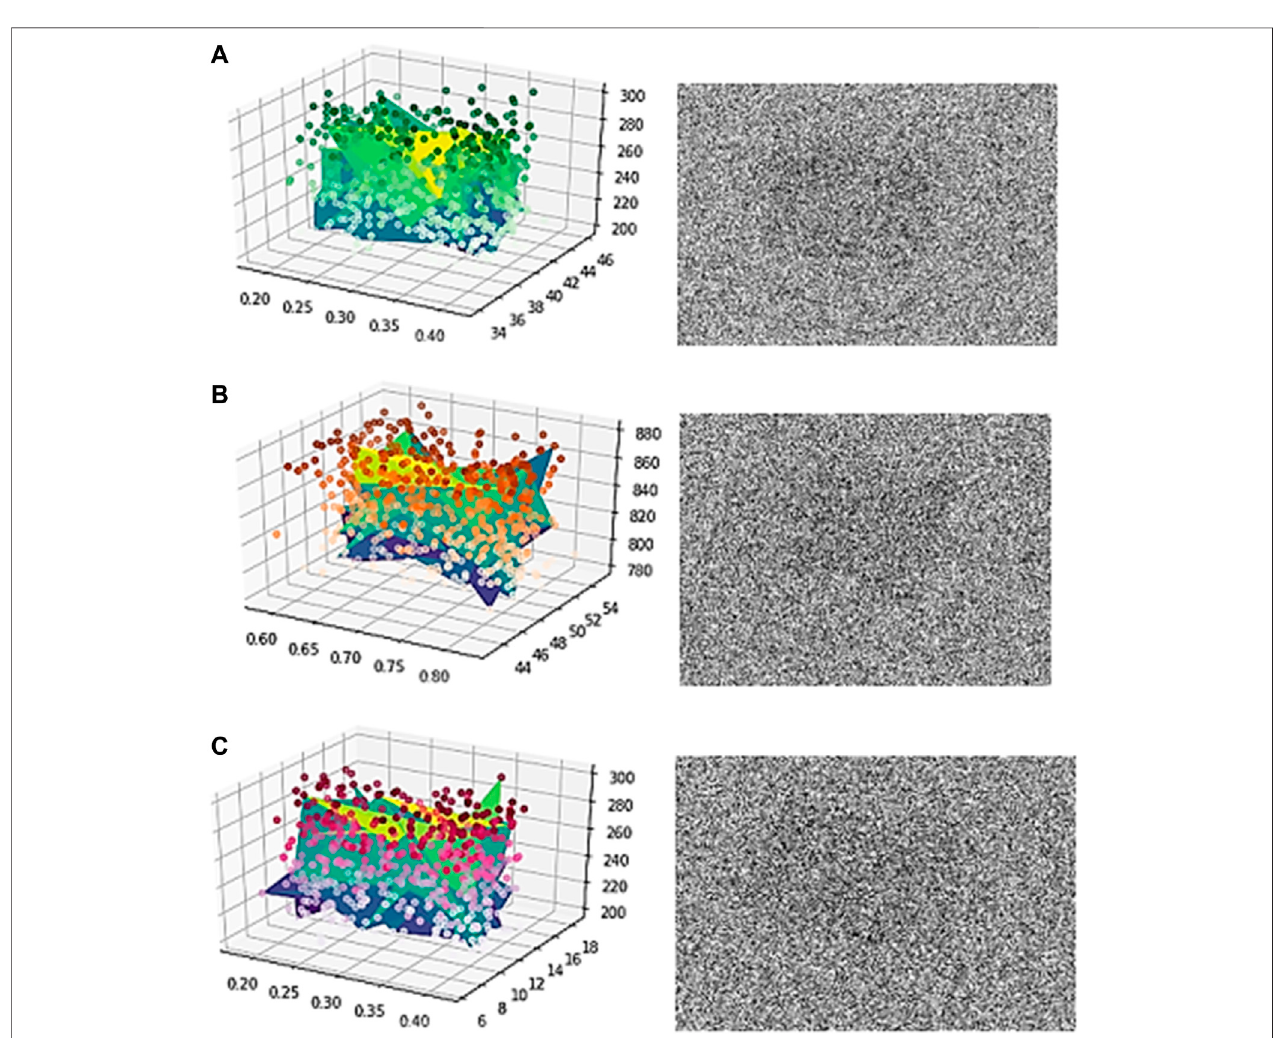
FIGURE 11 | (A, B, C) Consumption data encryption.